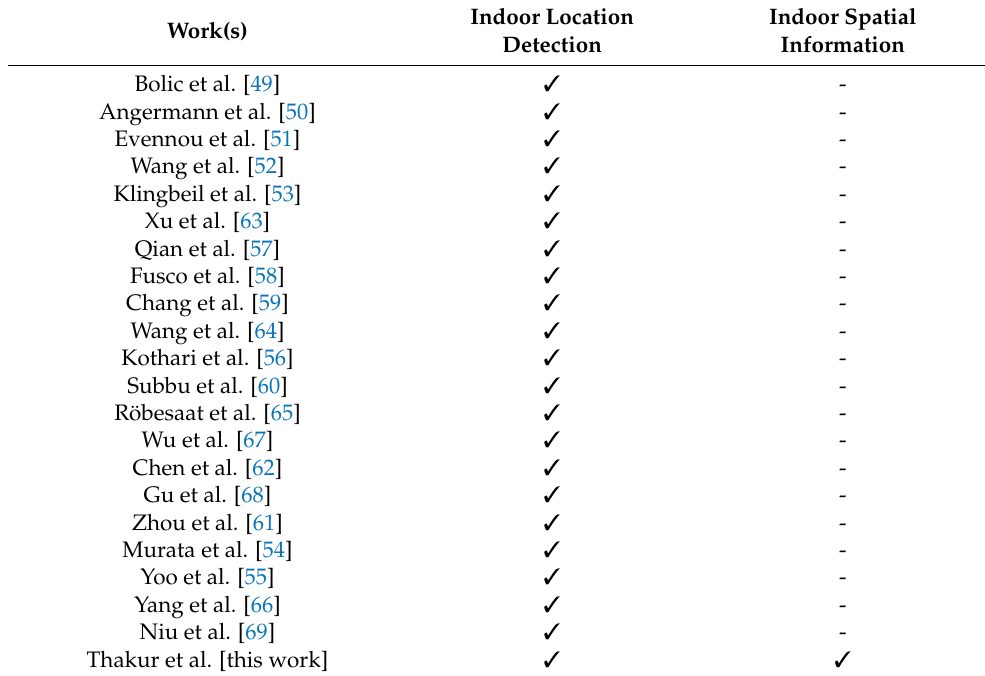
Table 7. Comparison of the functionality of indoor spatial information detection in our proposed framework with other similar works in this field.